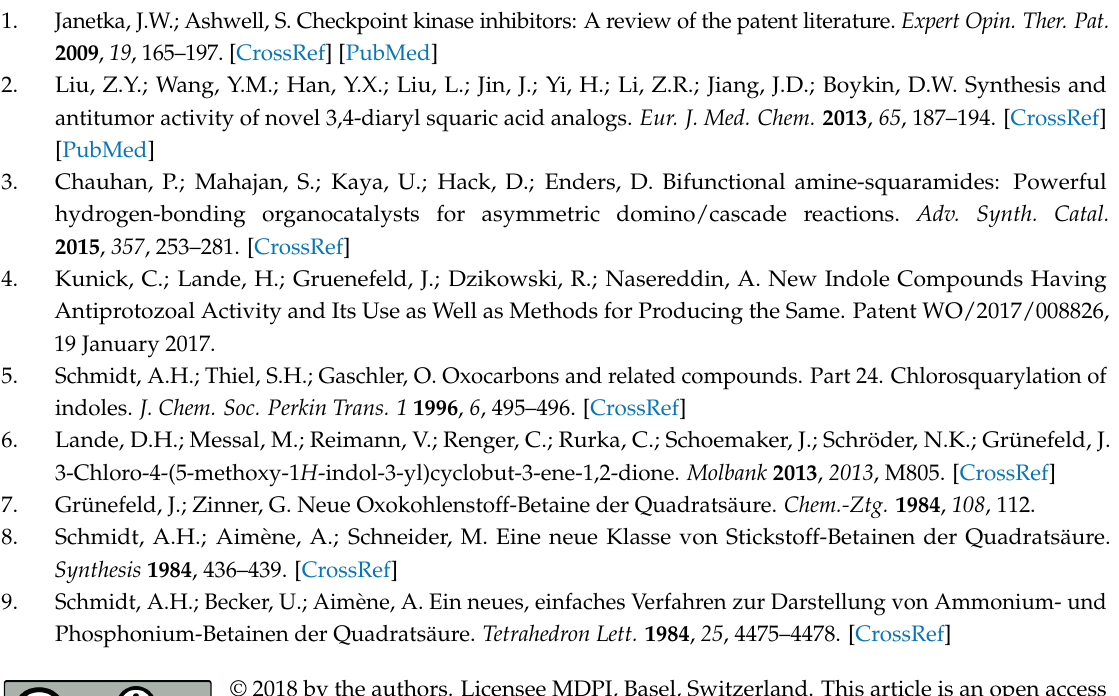
Supplementary Materials: The following are available online: Figure S1: 1 H-NMR, Figure S2: 13 C-NMR, Figure S3. H,H-COSY, Figure S4. H,C-HMBC, Figure S5. H,N-HMBC, Figure S6. IR, Figure S7: mass